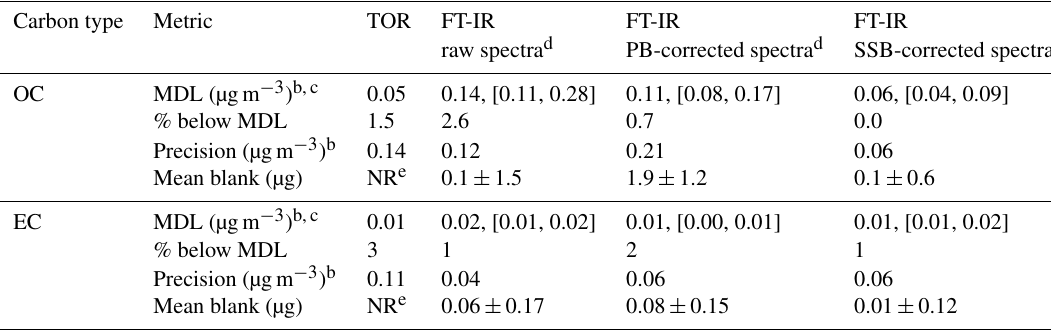
Table 5. MDL and precision for FT-IR OC and TOR